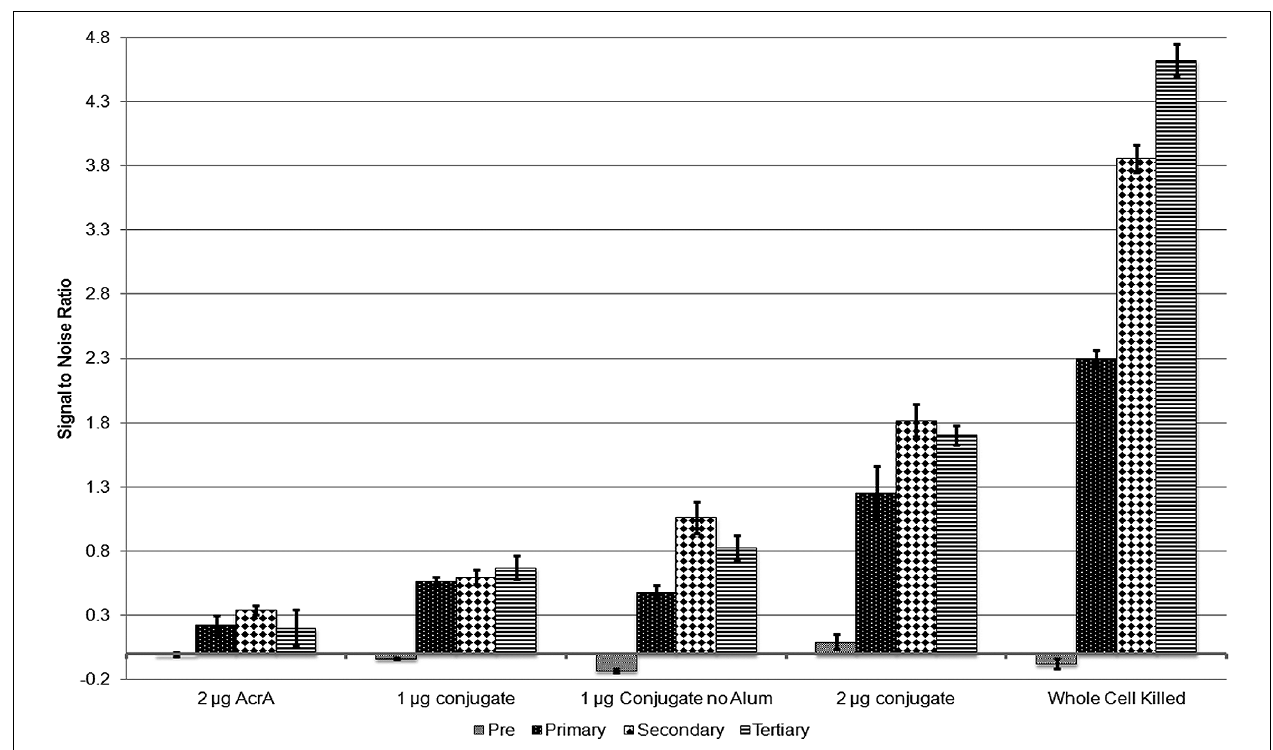
FIGURE 6 | ELISA of the IgG immune response of immunized mice toward whole-cell extracts of B. pseudomallei. All data were normalized to the PBS-injected control mice, and no response was observed in all groups prior to immunization. A low level of response